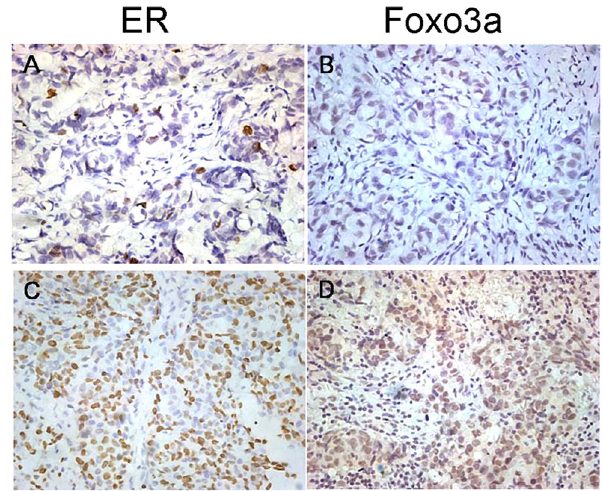
Figure 2. Foxo3a protein expression in distinct ER + and ER 2 paraffin-embedded breast cancer tissue samples analyzed by IHC. The IHC results were shown at 6 400 magnification. Expression of ER and Foxo3a in malignant mammary gland tumors. ER-negative breast cancer case (A) displayed low expression of Foxo3a (B);ER- positive breast cancer case(C) showed high expression of Foxo3a (D).